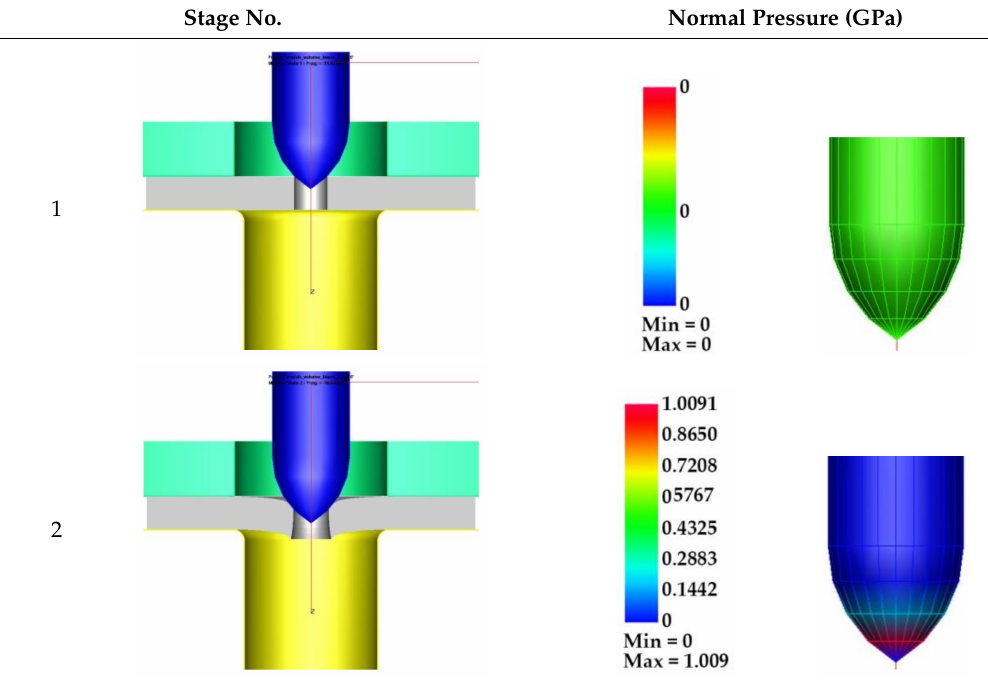
Figure 13. The simulation of the hole-flanging process: ( a ) simulation model; ( b ) normal pressure. As a result of the numerical simulation, the normal pressure on the punch surface was evaluated (Figure 13b) in 10 stages during the punch path (Table 6). Table 6. The hole-flanging process-results of the numerical simulation (selected stages). Stage